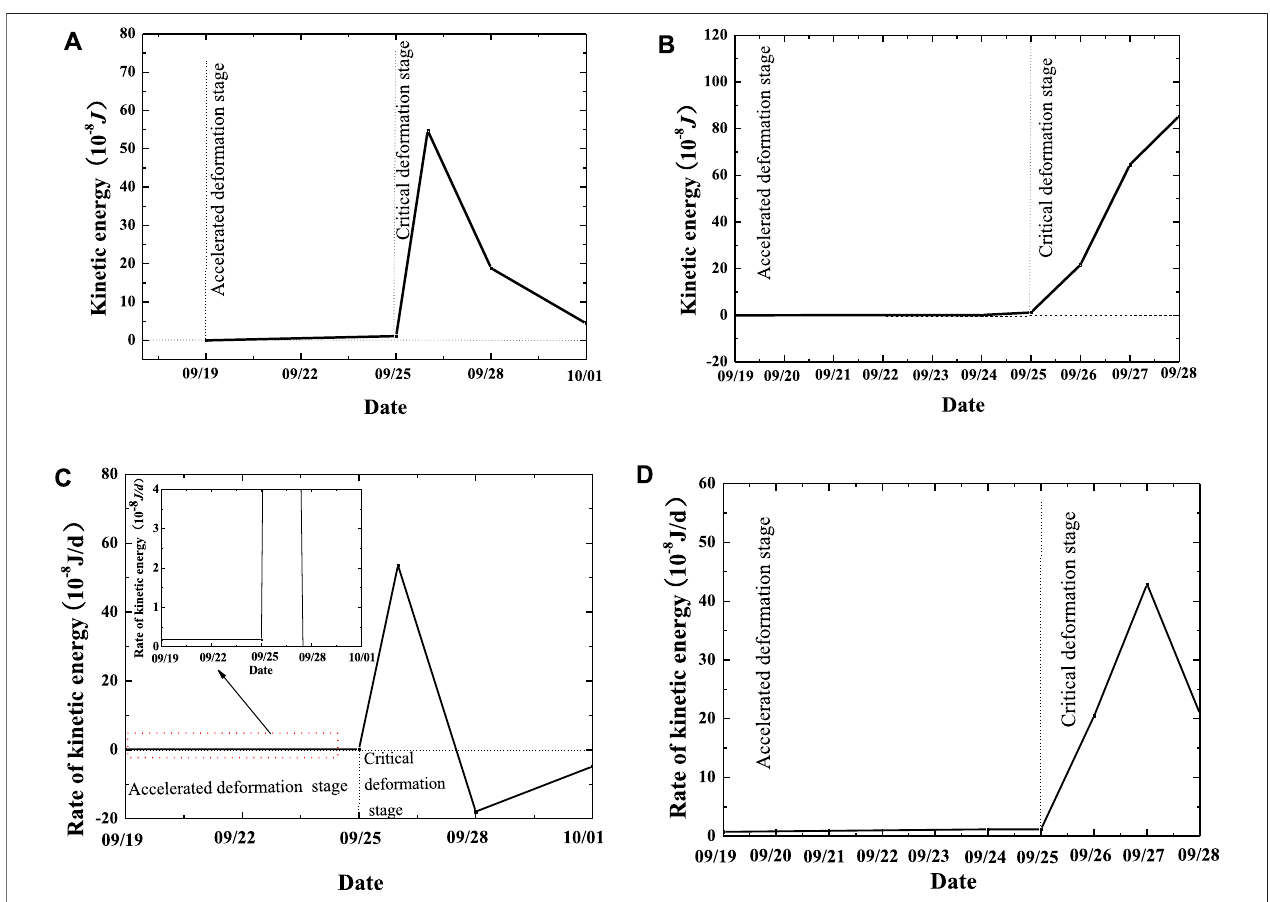
FIGURE 7 | Kinetic energy motion during sliding based on the deep displacement: kinetic energy vs time obtained from (A) 4# SAA and (B) 5#SAA; rate of kinetic energy vs time obtained from (C) 4#SAA and (D) 5#SAA.